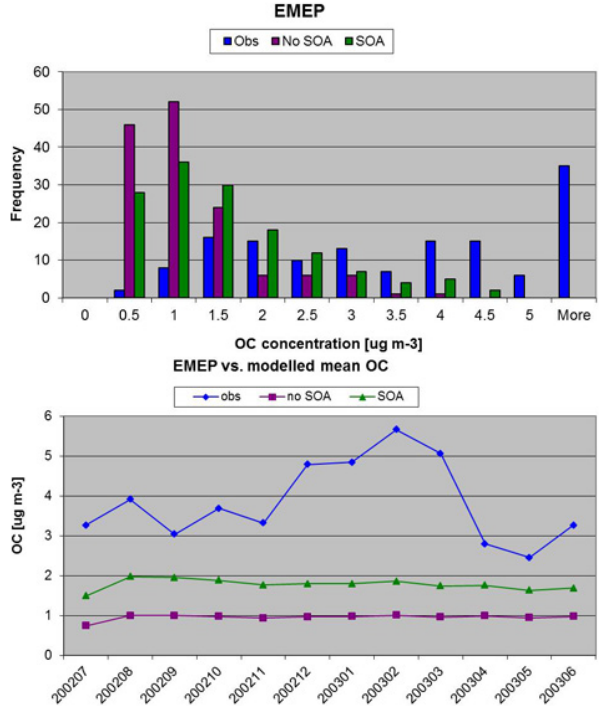
Fig. 14. EMEP observations and modelled OC aerosol